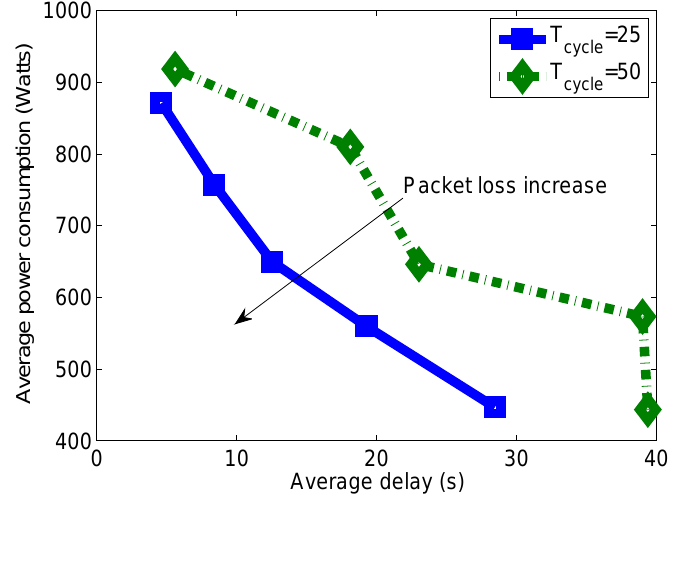
for different T on cycles